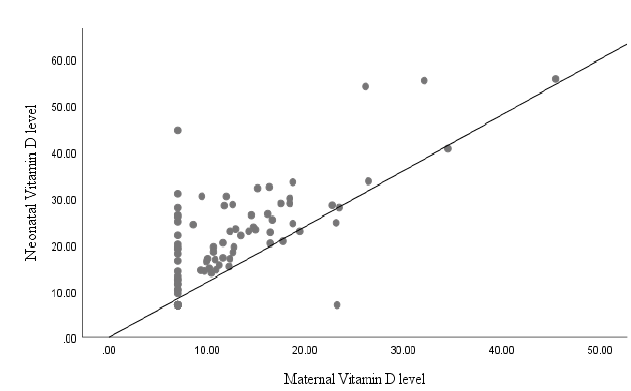
Figure 2 : Correlation between maternal and neonatal Vitamin D levels (r = 0.715, p< 0.0001 ((highly significant)).